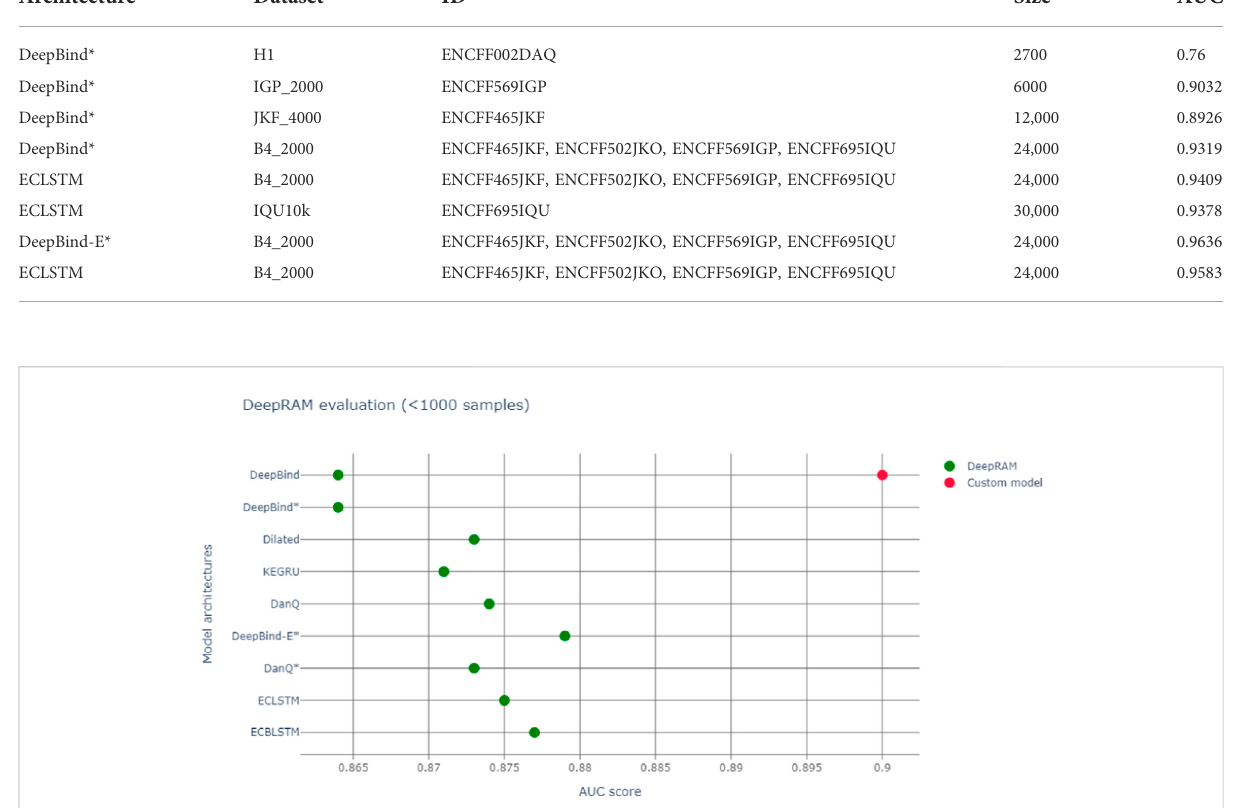
FIGURE 3 Red dot represents AUC of our model, green dots the various DeepBind architectures ((Hassanzadeh and Wang, 2016) and Refs.